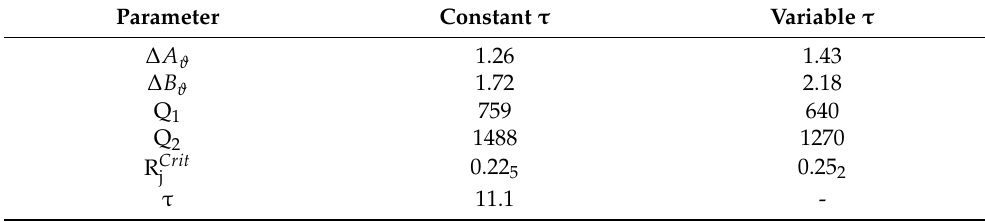
Figure A1. Best fit of the experimental data using Equation (13) for alginate from L. hyperborea . Black line represents the best fitting using a constant value of τ , while the red curve represents the best fitting with τ = τ (R j ), using the values of the dotted curve of Figure 3a. Table A1. Parameters obtained from the minimization of Equation (13) using τ as defined in the column headings.